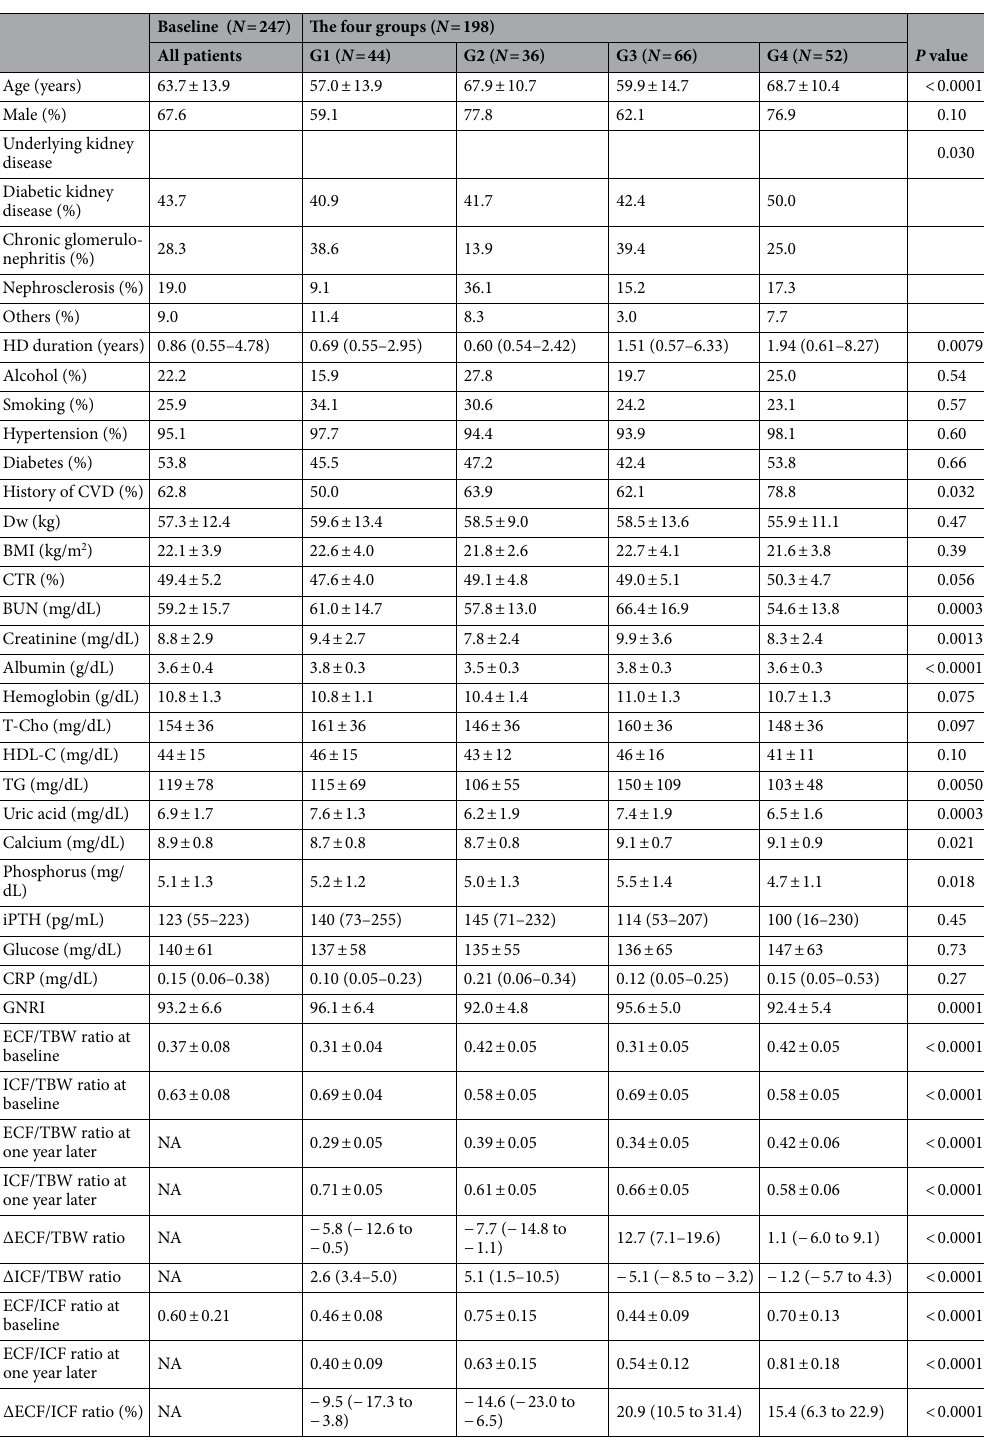
Table 1. Baseline characteristics of the study participants. BMI, body mass index; BUN, blood urea nitrogen; CRP, C-reactive protein; CTR, cardiothoracic ratio; CVD, cardiovascular disease; Dw, dry